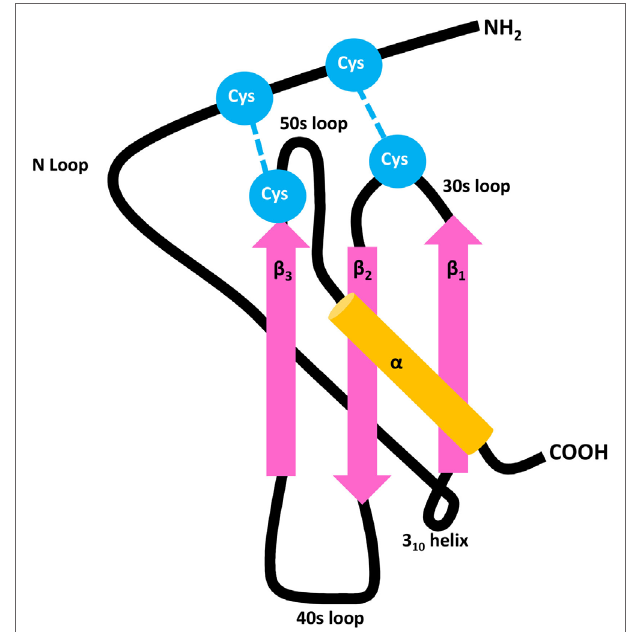
FiGuRe 1 | General structure of CXC chemokines. Chemokines contain three antiparallel β strands (pink) and a COOH-terminal α -helix (orange), mutually connected by 30s, 40s, and 50s loops. The flexible NH 2 -terminal domain is followed by an N loop and 3 10 helix, respectively. The 3D structure of the mature secreted protein is stabilized by two disulfide bridges which are formed by four conserved Cys residues